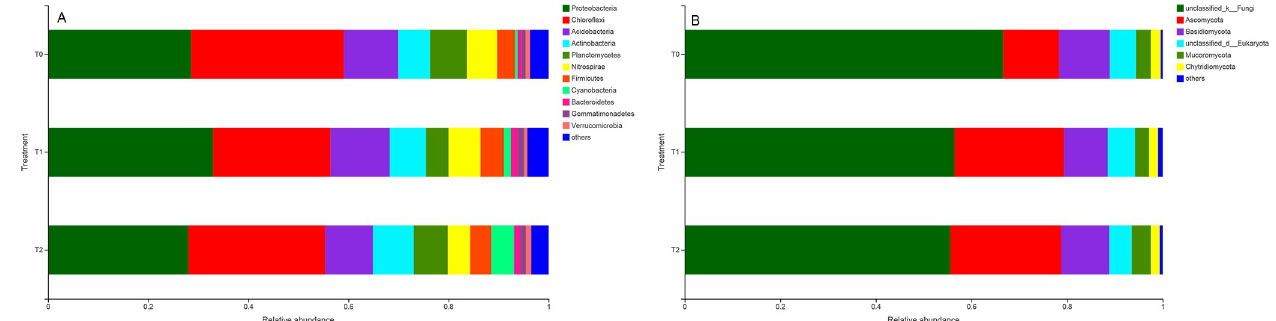
Fig 6. Average relative abundance of dominant bacterial (A) and fungal (B) phyla ( > 1.0%) in different fertilization and irrigation regimes. The abundance is expressed as the average percentage of the targeted sequences to the total high-quality bacterial and fungal sequences of samples from triplicate plots of each fertilization regime, respectively. Notes: ‘Others’ refer to those identified phyla with lower than 1.0% relative abundance in all the samples. T0 = Traditional irrigation; T1 = Traditional irrigation and fertilization practice; T2 = Water-saving irrigation and optimizing